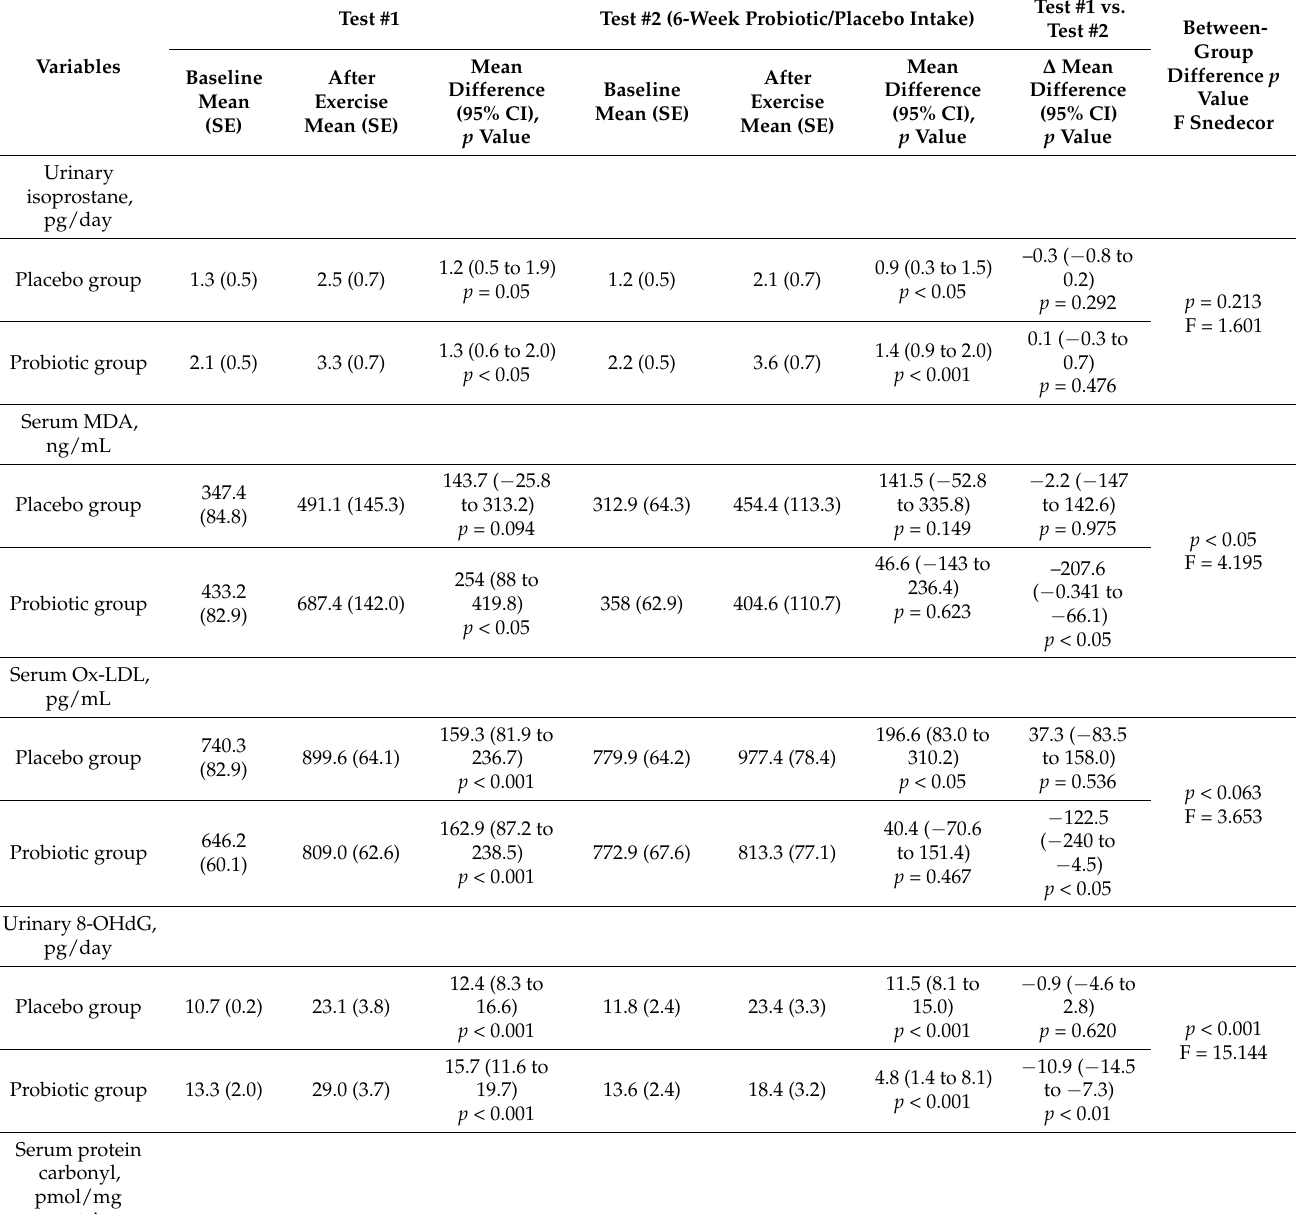
Table 1. Results of lipid, protein, and DNA-related oxidative stress biomarkers and antioxidative enzymes.